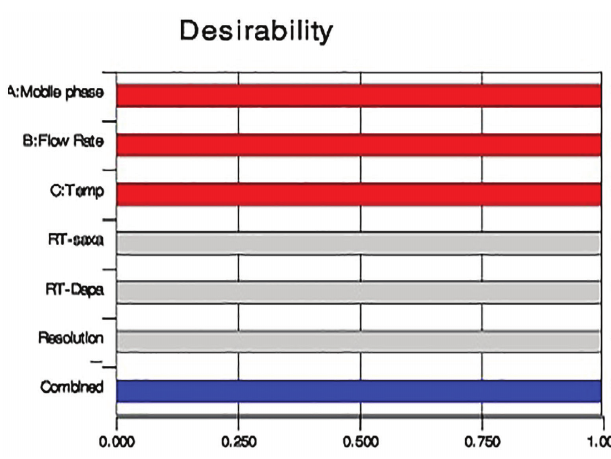
FIGURE 6 - Desirability function representation basis